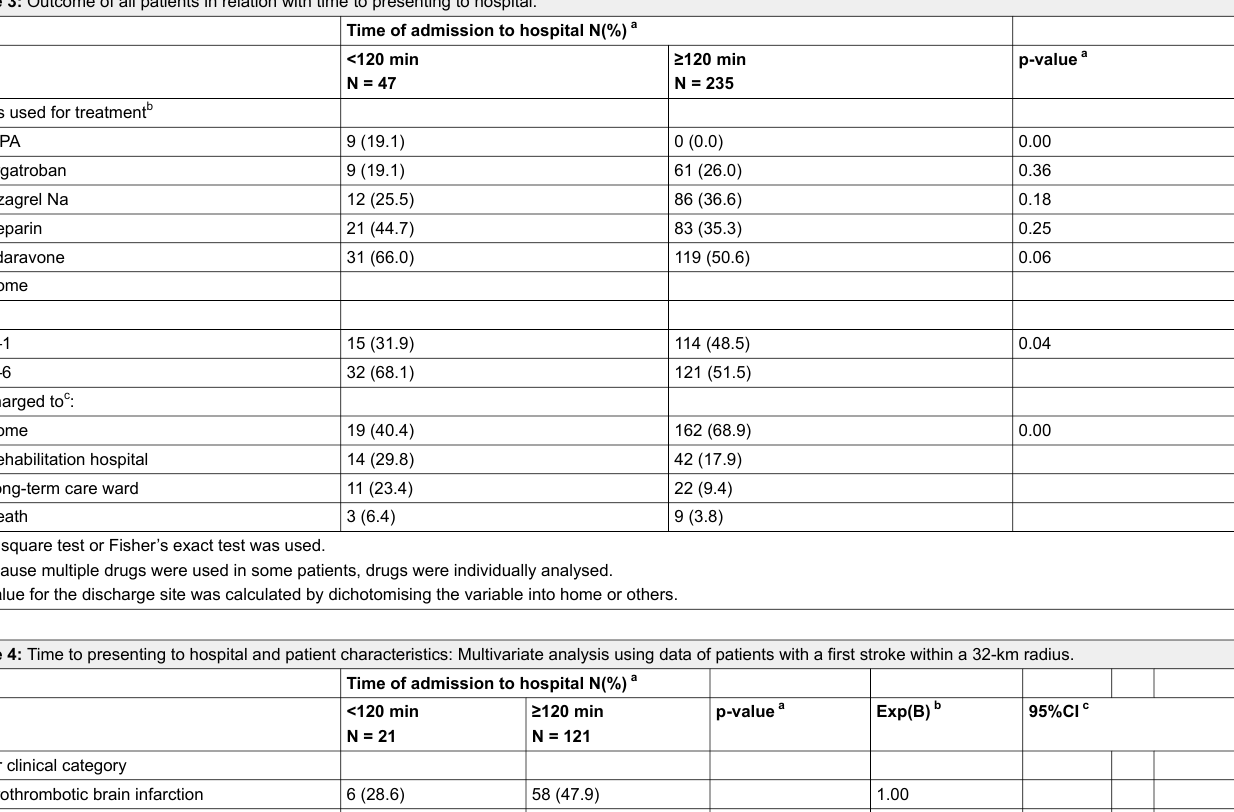
Table 3: Outcome of all patients in relation with time to presenting to hospital.